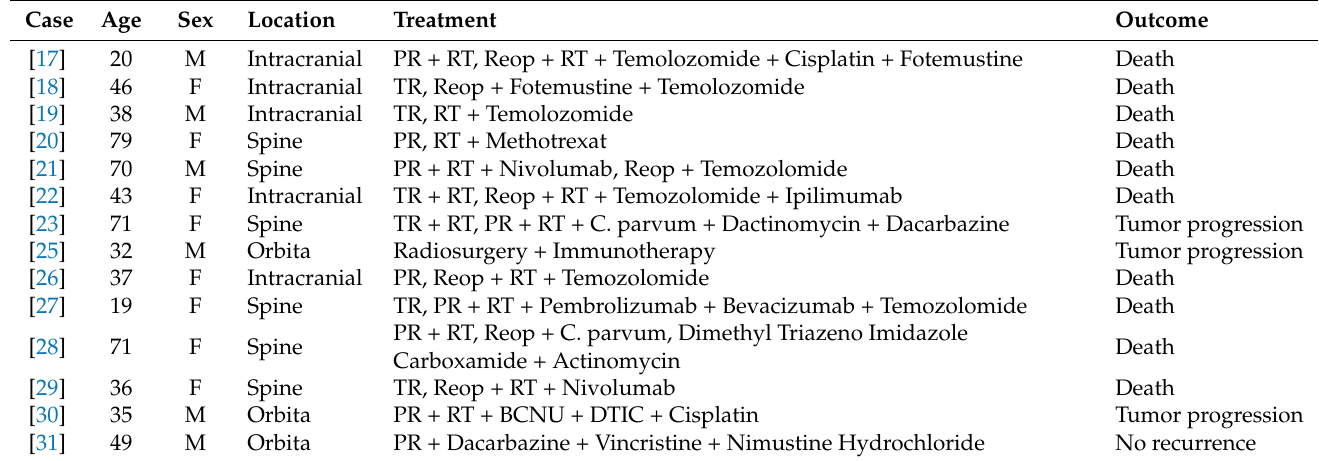
Table 1. Overview of all cases in which adjuvant chemo- or immunotherapy was applied: In all cases, the adjuvant therapy failed, and tumor progression was observed. Ten patients died because of MM growth and its